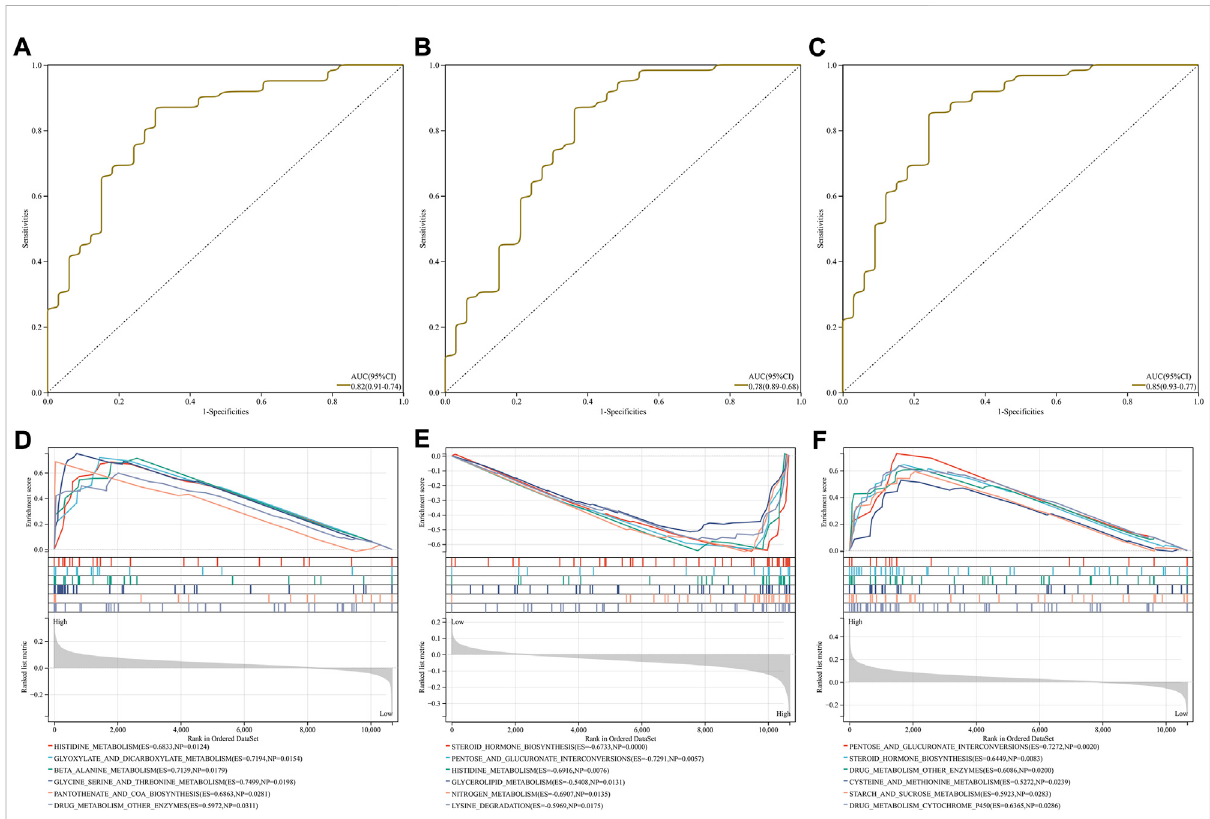
FIGURE 4 Diagnostic ef fi cacy and involved signaling pathways of characteristic RBPs in IgA nephropathy. (A – C) ROCs of (A) DDX27, (B) RCL1, and (C) TFB2M in diagnosing IgA nephropathy. (D – F) KEGG pathways involved in (D) DDX27, (E) RCL1, and (F)